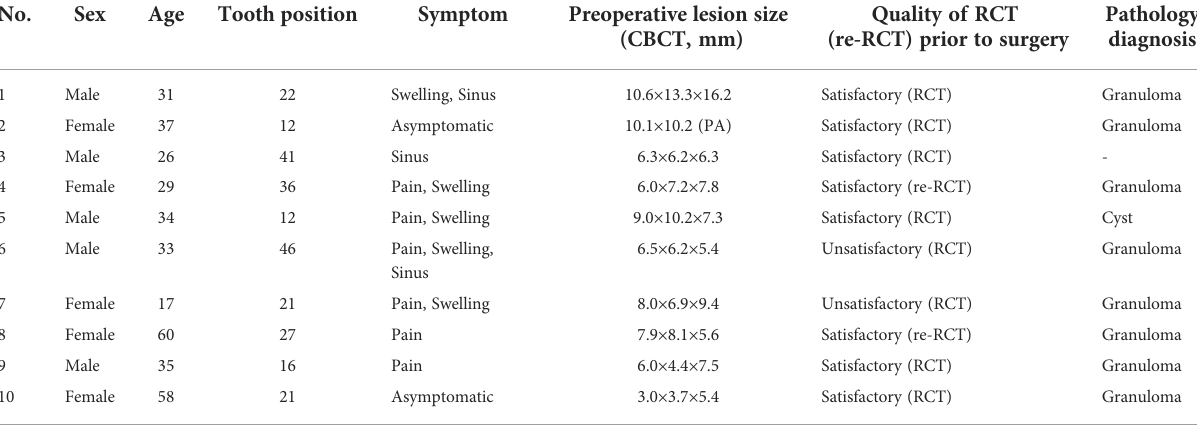
TABLE 1 Clinical information of Included patients (n =